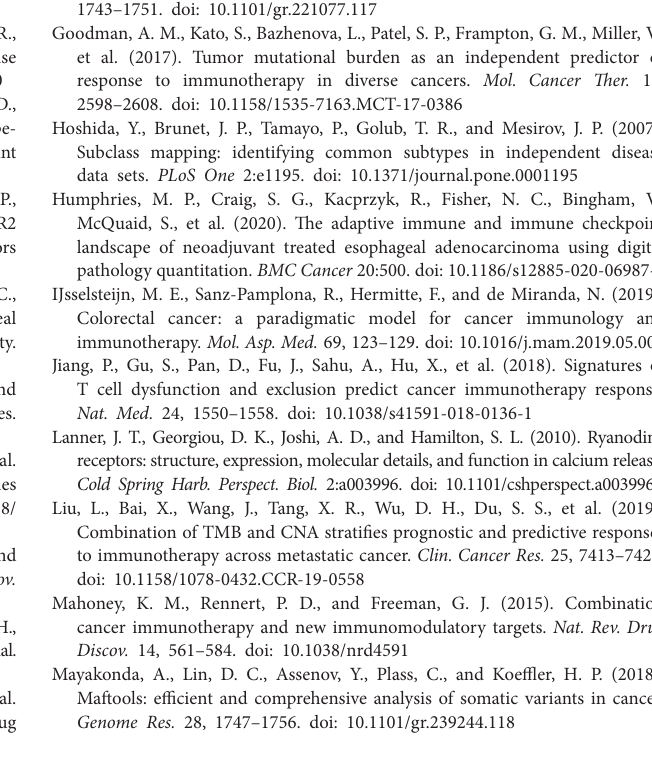
Supplementary Figure S1 | Kaplan-Meier survival analysis of patients with gene mutations. (A) Kaplan-Meier survival analysis between patients with high and low tumor mutation burden. (B) Kaplan-Meier survival analysis between patients with and without gene mutations. Supplementary Figure S2 | Distribution of immune infiltration signatures between patients with and without RYR2 mutation. (A) The infiltration abundance of 28 immune cell subsets evaluated by ssGSEA algorithm. (B) The immune cell infiltration pattern assessed by CIBERSORT algorithm. (C) The distribution of stromal, immune, and ESTIMATE scores and tumor purity between patients with and without RYR2